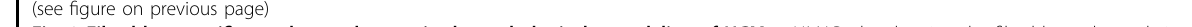
Fig. 3 Fibroblast-speci fi c regulatory changes in the pathological remodeling of HCM. a UMAP plot showing the fi broblast subpopulations. b Heatmap showing the molecular signature of each subpopulation. c Split violin plots showing the expression of the markers for activated fi broblasts. d Hierarchical clustering of the subpopulations. e Relative proportion of each subpopulation in the fi broblasts from each condition. + : expansion; – : contraction. f Immuno fl uorescence staining con fi rmed the presence of the four subpopulations in cardiac tissues from HCM patients. Fibroblasts are marked by PDGFRA. Scale bar: 10 μ m. g Representative terms enriched in the upregulated genes in fi broblasts from HCM patients than those from healthy donors. Adjusted P -value < 0.05, hypergeometric test. h UMAP plot showing the subpopulations FB1 and FB2 (left panel), and the cellular trajectory reconstructed for fi broblast activation using Slingshot (right panel). The arrow shows the direction of cellular state changes. i Density curves showing the distributions of the two fi broblast subpopulations (left panel) and the fi broblasts from different conditions along the trajectory (right panel). ** P -value < 2.2e-16, Kolmogorov-Smirnov test. j Heatmaps showing the expression dynamics of the 432 genes with signi fi cantly different patterns along the trajectory between the two conditions. These genes were detected by differential expression pattern analysis using the “ conditionTest ” function of tradeSeq and were categorized into 7 gene clusters by hierarchical clustering. The signi fi cance threshold was set to an adjusted P -value < 0.05. k The potential key genes that were prioritized based on the results of three independent analyses including the difference in expression patterns, the fold change of expression levels, and the centrality change in GRNs. l Smoothed expression curves of representative candidate genes along the trajectory in both conditions. m Western blot assays con fi rmed that the protein levels of AEBP1 and RUNX1 were signi fi cantly changed in cardiac tissues from HCM patients ( n = 5) compared with those from healthy donors ( n = 5). * P < 0.05, ** P < 0.01, Wilcoxon rank-sum